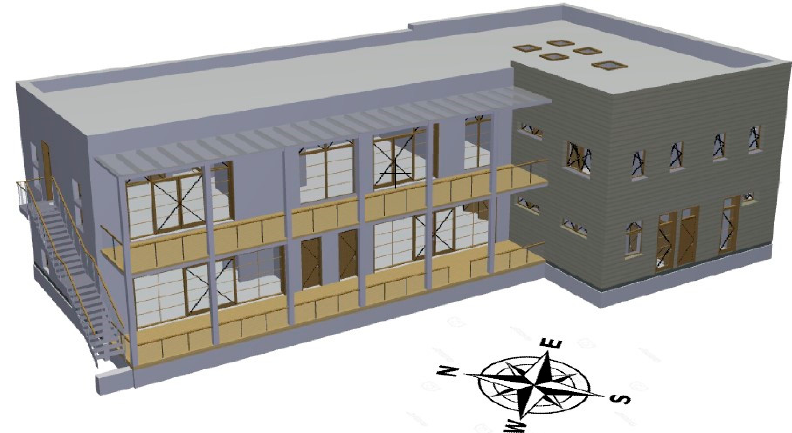
Figure 2. Display of the new preschool building in a comprehensive 3D BIM © 2020, IGI